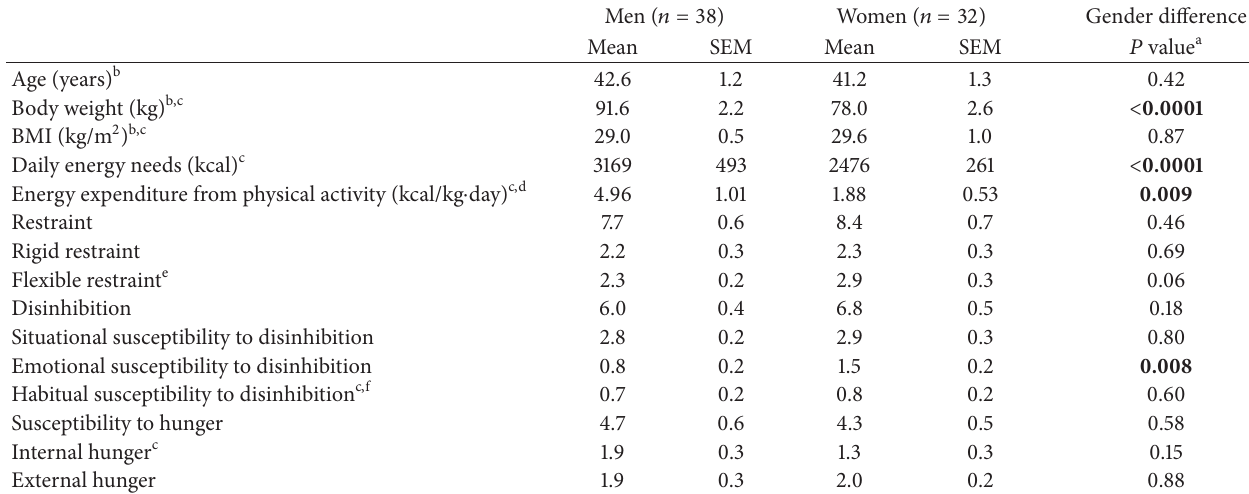
Table 3: Characteristics of men and premenopausal women before the 4-week fully controlled Mediterranean diet intervention.